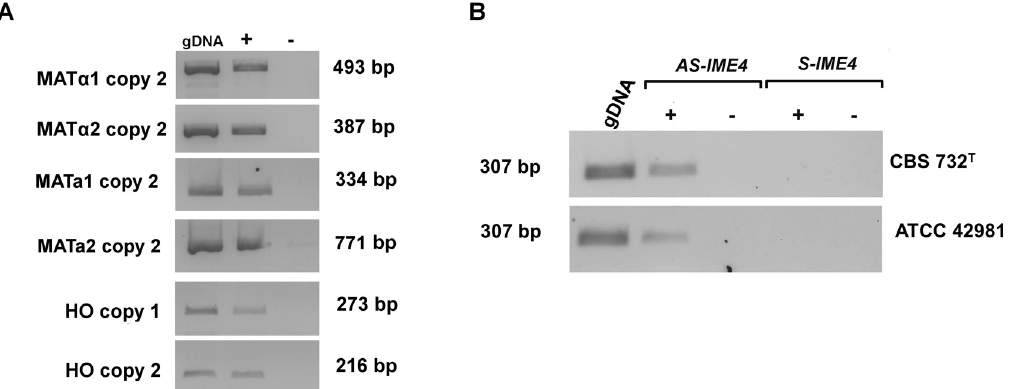
Fig 7. Expression pattern of mating-type, HO and IME 4 genes. Panel A reports positive amplified cDNAs generated with MAT and HO copy variant- specific primers from ATCC 42981 unstressed cells in stationary growth phase. Panel B depicts IME4 -specific PCR products generated from CBS 732 T and ATCC 42981 cDNA IME4 antisense (AS- IME4 lncRNA) and sense transcripts (S- IME4 mRNA), respectively. +/- RT indicates addition of reverse transcriptase to the cDNA synthesis reaction. For each RT-PCR reaction gDNA was used as positive control. Abbreviations: AS, anti-sense long non-coding RNA; S, sense mRNA.